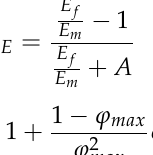
Table 4. The dispersion and polar surface tension components of the polymers used in the study, and the reversible work of adhesion in their composites.